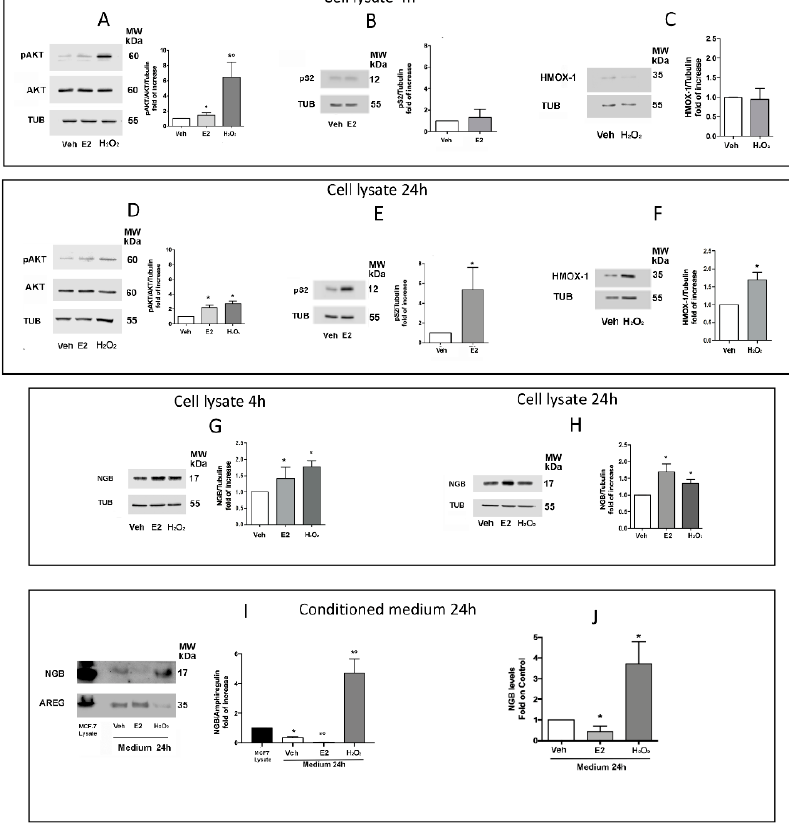
Figure 2. E ff ect of E2 and H 2 O 2 stimulation on intracellular and extracellular NGB levels. Western blot images (left) and densitometric analysis (right) of intracellular (cell lysate) levels of pAKT(S473) ( A , D